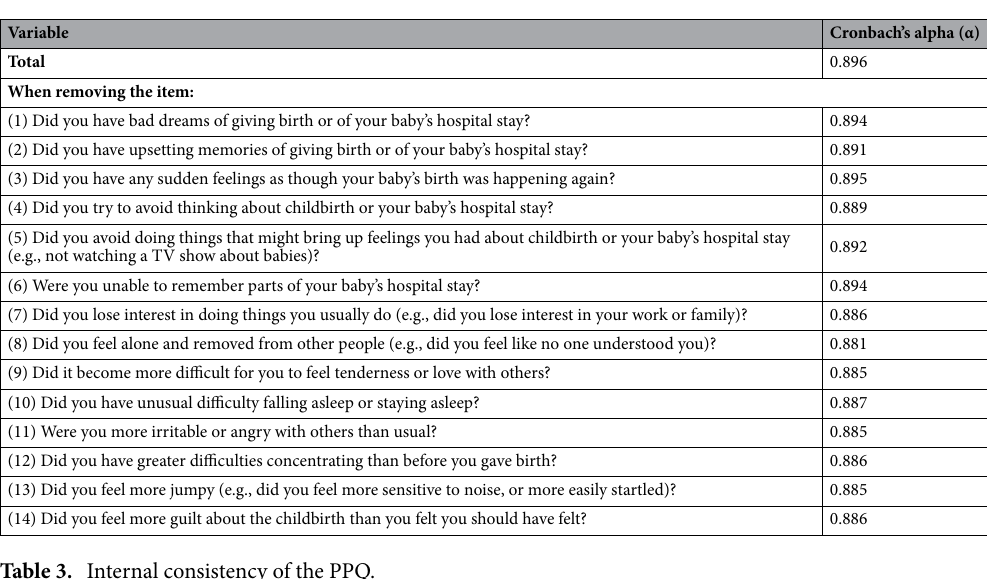
Table 3. Internal consistency of the